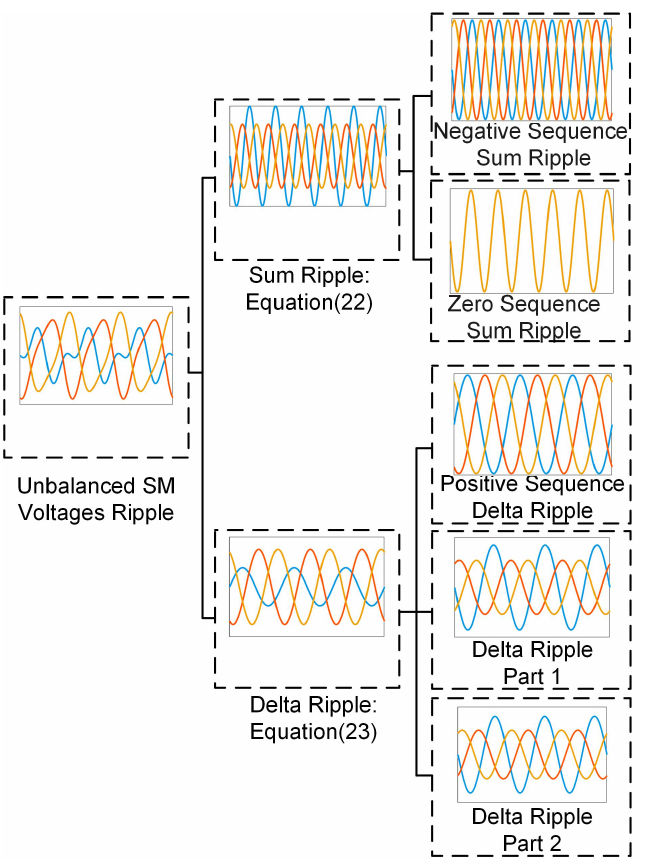
Figure 3. Illustration of the MMC’s submodule-capacitor voltage-ripple components under unbal- anced grid conditions.